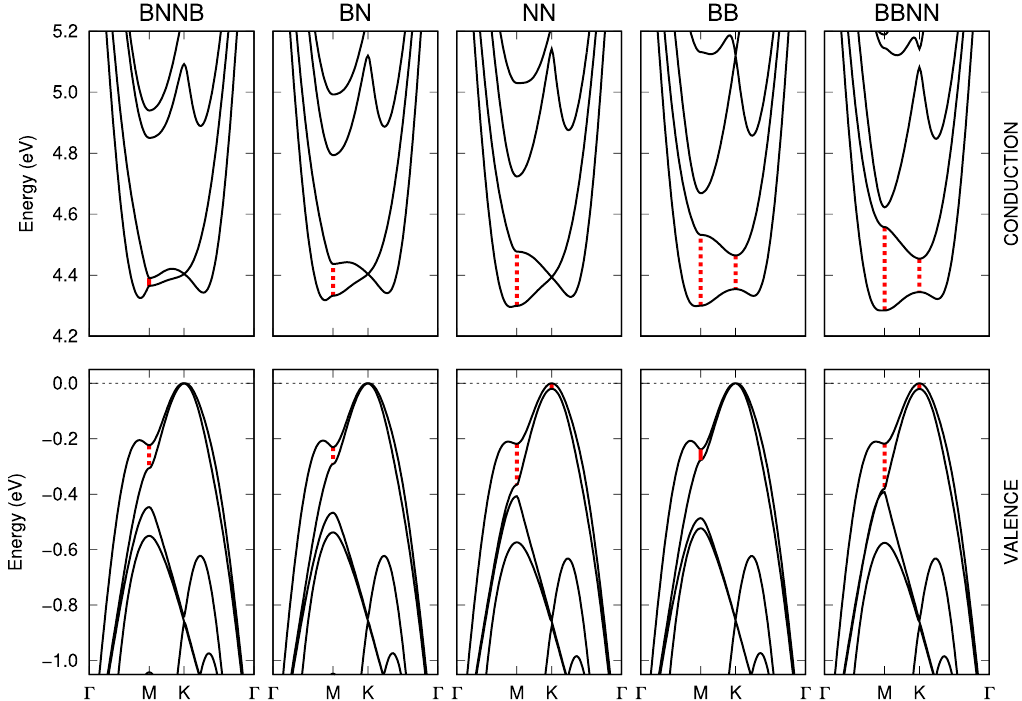
Figure 3: Bottom conduction and top valence of the five principal stackings in the ( 1,2 ) supercell. Red vertical dashed lines highlight the notable splittings at M and K reported also in Table